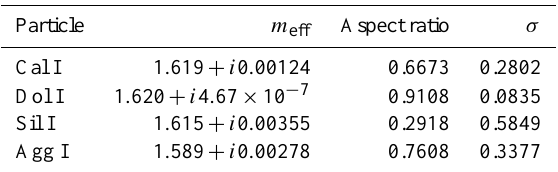
Fig. 6. Shapes of a prolate spheroid and five Gaussian random spheres derived as simplified models for each dust particle. The three black cross sections of each dust particle were used in deriving the corresponding Gaussian random sphere statistics. Table 2. Effective refractive indices m eff and shape model parame- ters. The covariance functions for the Gaussian random sphere are not